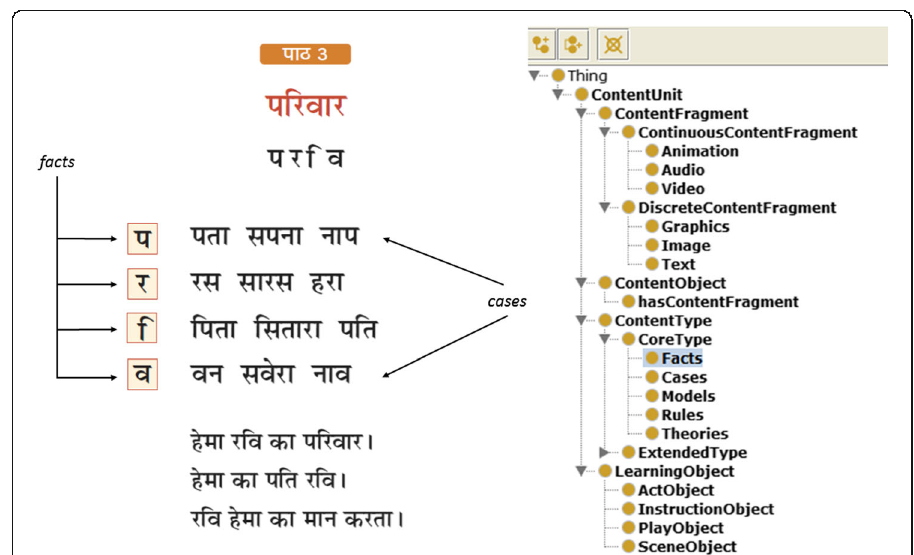
Fig. 8 A fragment of